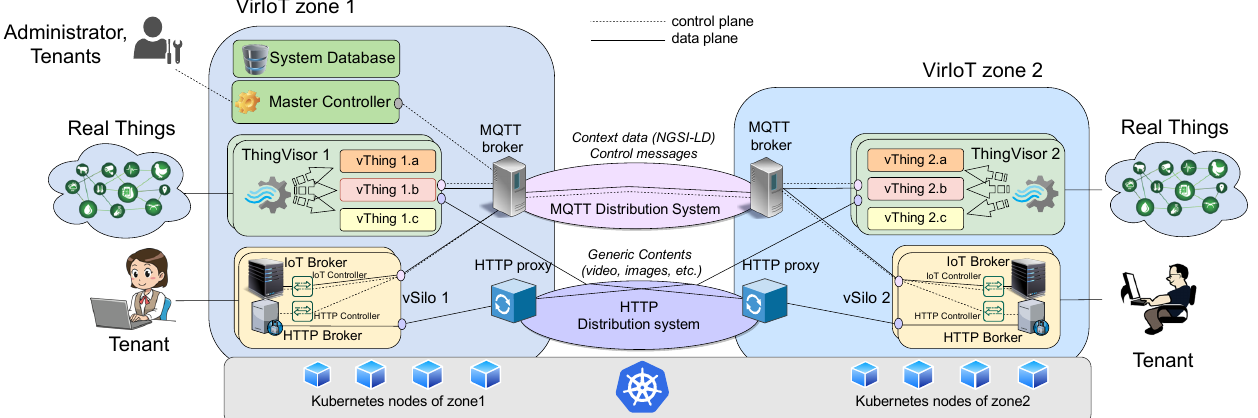
Figure 4. VirIoT system